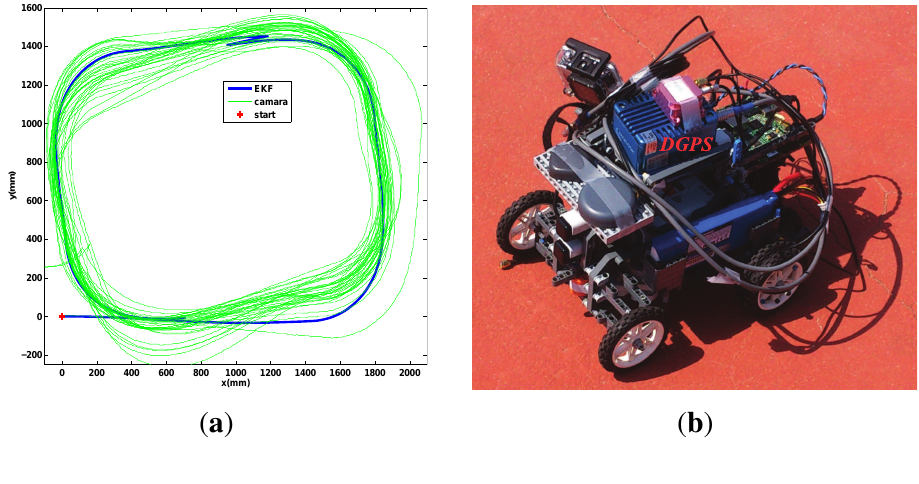
Figure 11. Ackermann indoor test with the zenithal camera and outdoor setup with DGPS. ( a ) indoor test, 30 min; ( b ) Outdoor setup with DGPS for